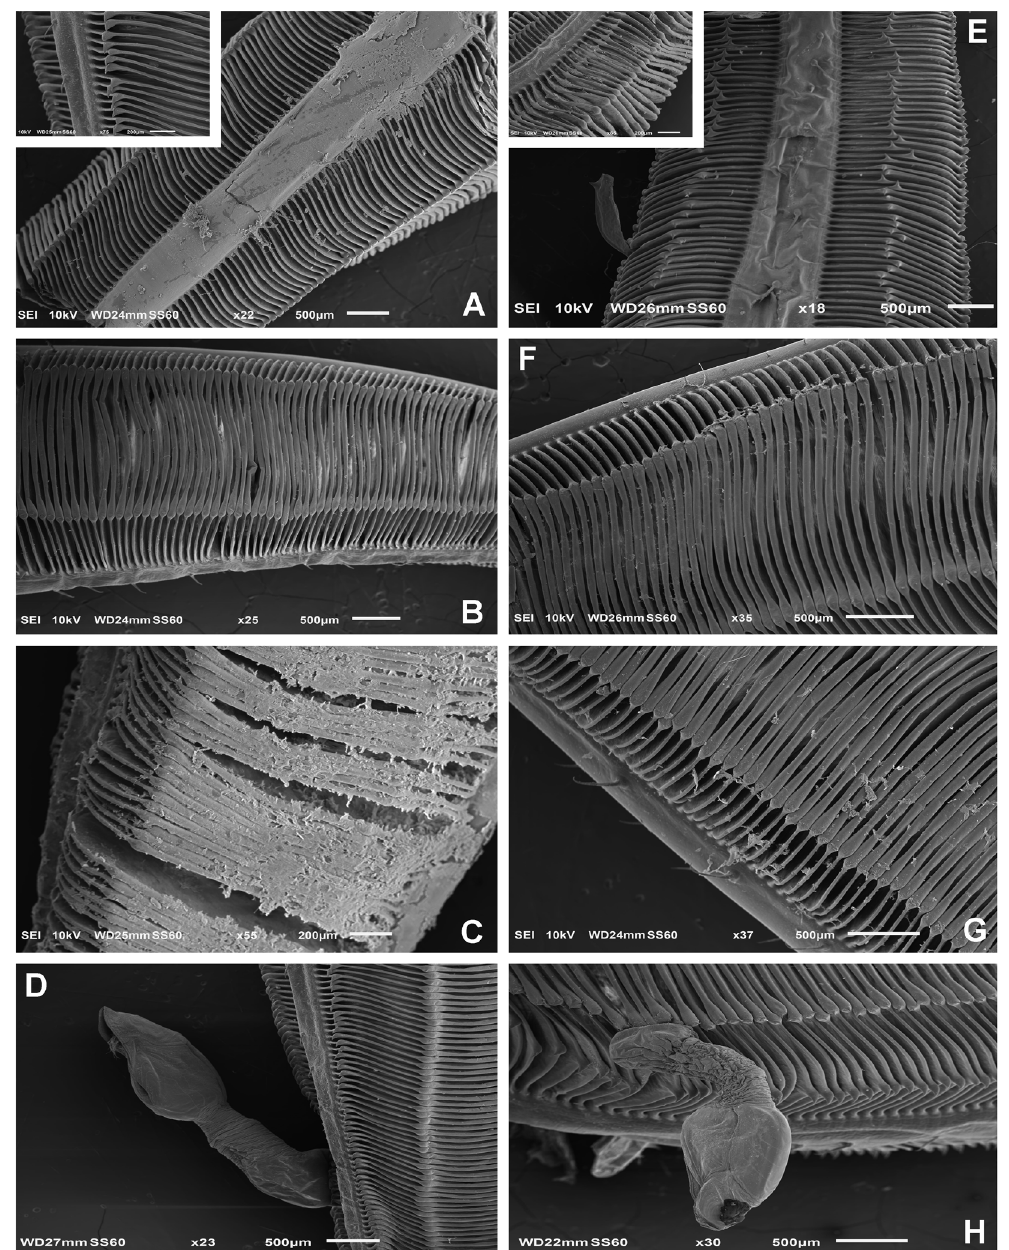
Figure 8. Gills from the ablation experiment, with images A–D from the side with the 3M epipod ablated and images E–H from the side with all gill grooming appendages intact. A. Dorsal view of gill, with the central axis and lamellae both fouled; inset showing “shark teeth” nodules on lamellae with minimal fouling. B. Ventral view of gill, with minimal fouling between lamellae. C. Ventral view of gill, with heavily fouled lamellae mostly of sediment. D. Fouling by a gooseneck barnacle attached to lamellae, with minimal. E. Dorsal view of gill, with the central axis and lamellae both fouled; inset showing “shark teeth” nodules on lamellae with fouling. F. Ventral view of gill, with fouling in between lamellae. G. Ventral view of gill, with fouling on gill surface and simple setae along edge. H. Fouling by a gooseneck barnacle attached to lamellae, with minimal